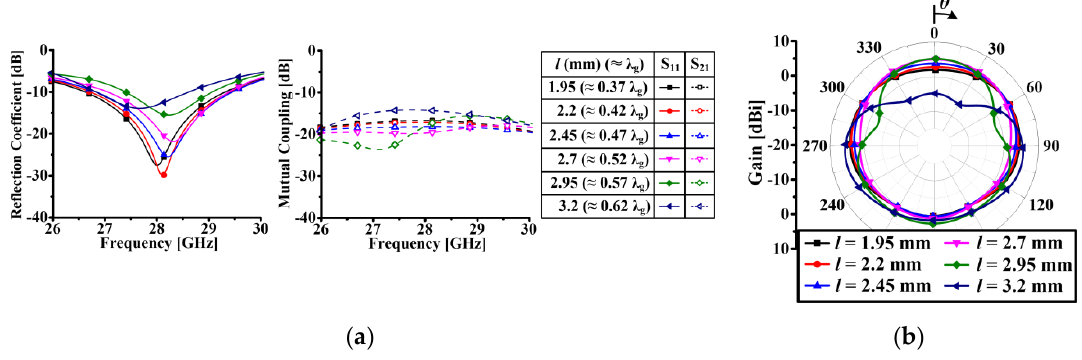
Figure 8. Parameter studies of the length of the director ( d is fixed at 1.6 mm): ( a ) simulated results of the reflection coefficient and mutual coupling with various lengths of the director ( l ), and ( b ) simulated radiation patterns with various lengths ( l ) in the xz plane at 28 GHz.